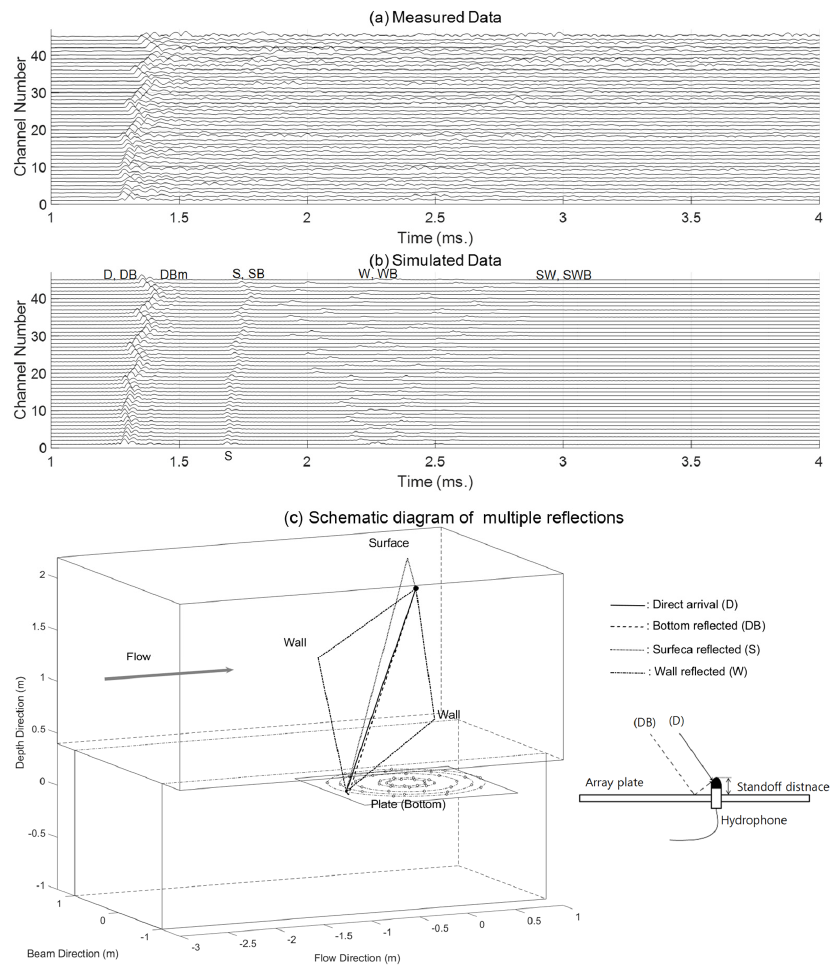
Figure 4. Measured ( a ) and simulated ( b ) Green’s function for the 45-channel hydrophones. The schematic diagram of multiple reflections and the detail for bottom-reflected arrival are shown in ( c ). DBm, multiple reflections between the acoustic window and array plate.